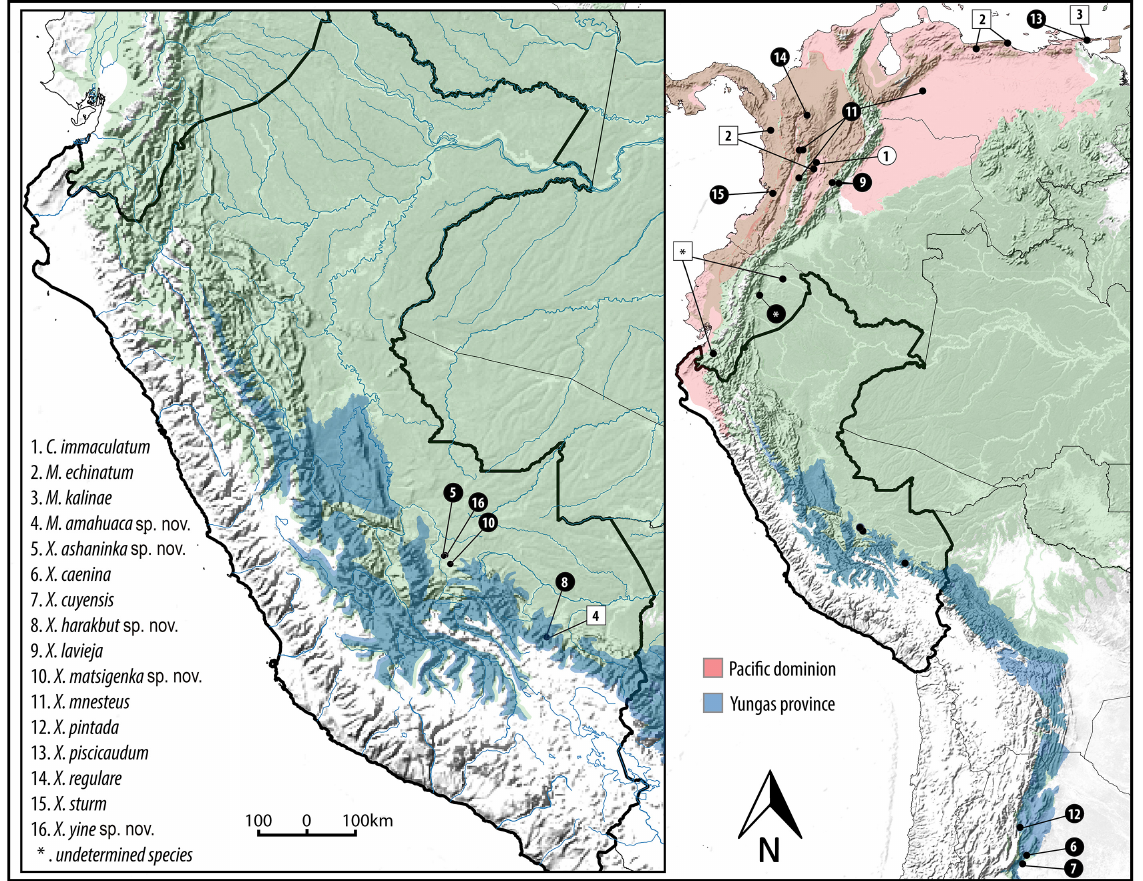
Fig. 1. Distribution of species of Xiphocentronidae Ross, 1949 in Western South America. Species of Machairocentron Schmid, 1982 are indicated in white boxes, those of Xiphocentron Brauer, 1870 in black circles and those of Caenocentron Schmid, 1982 in white circles. Tropical rainforests are shown in